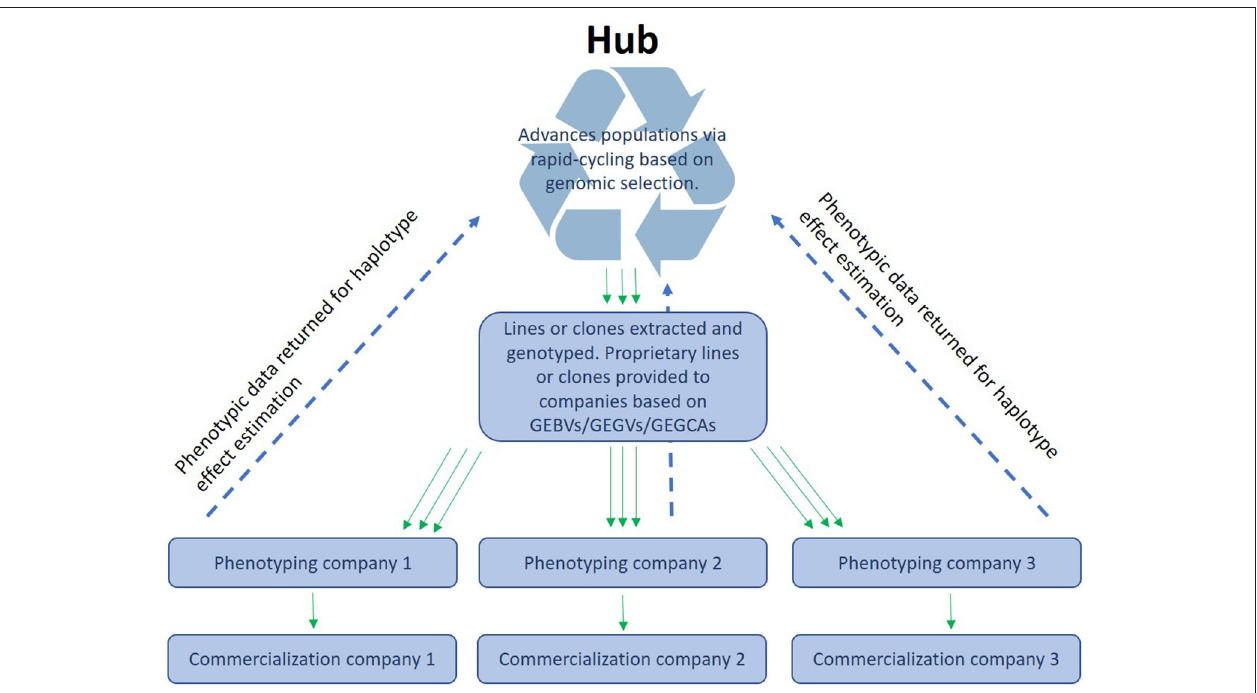
FIGURE 1 | Organization of open-source breeding: A hub receives the data (phenotypes and genotypes) from different programs or companies and makes the data available as training sets to enable the different ways of using genomic prediction (see main text).